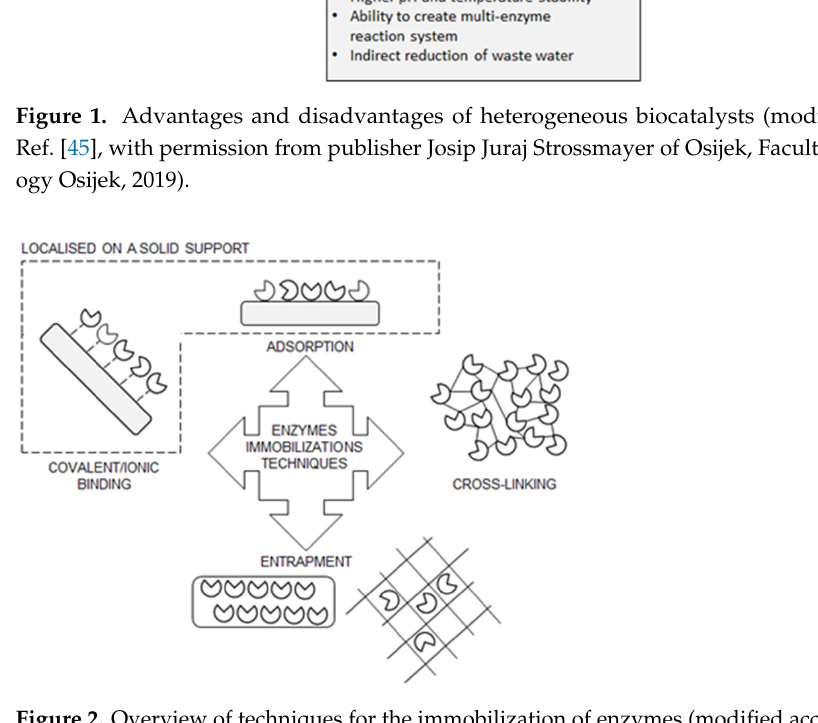
Figure 1. Advantages and disadvantages of heterogeneous biocatalysts (modified according to Ref. [45], with permission from publisher Josip Juraj Strossmayer of Osijek, Faculty of Food Tech- nology Osijek, 2019).